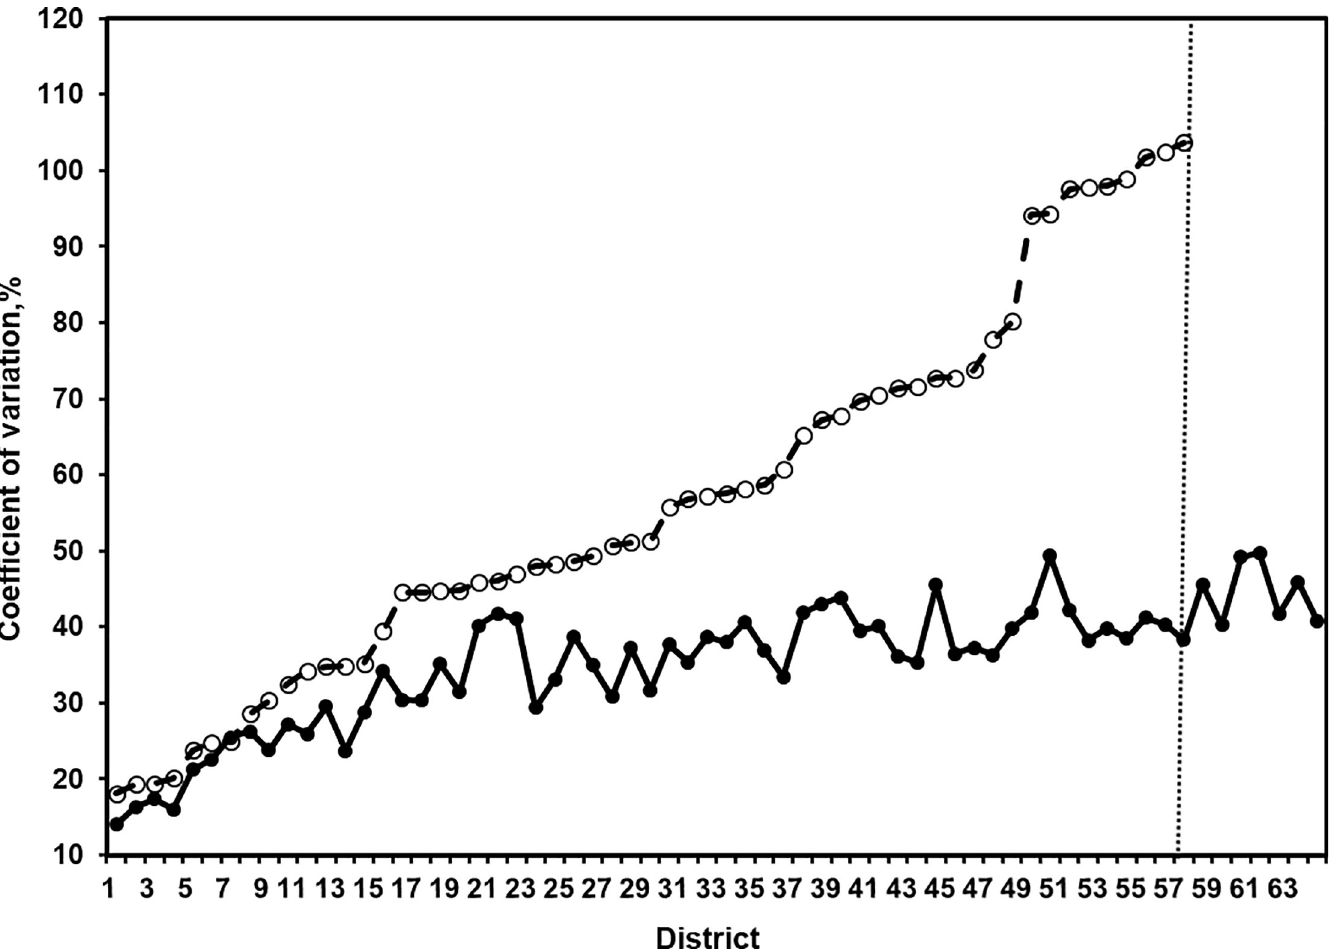
Fig 7. District-wise percentage coefficients of variation (CV, %) for the model-based small area estimate generated by EP (solid line, •) and the direct estimate (dash line, � ) for the diarrhoea prevalence in Bangladesh. Districts are arranged in increasing order of CV of direct estimates.